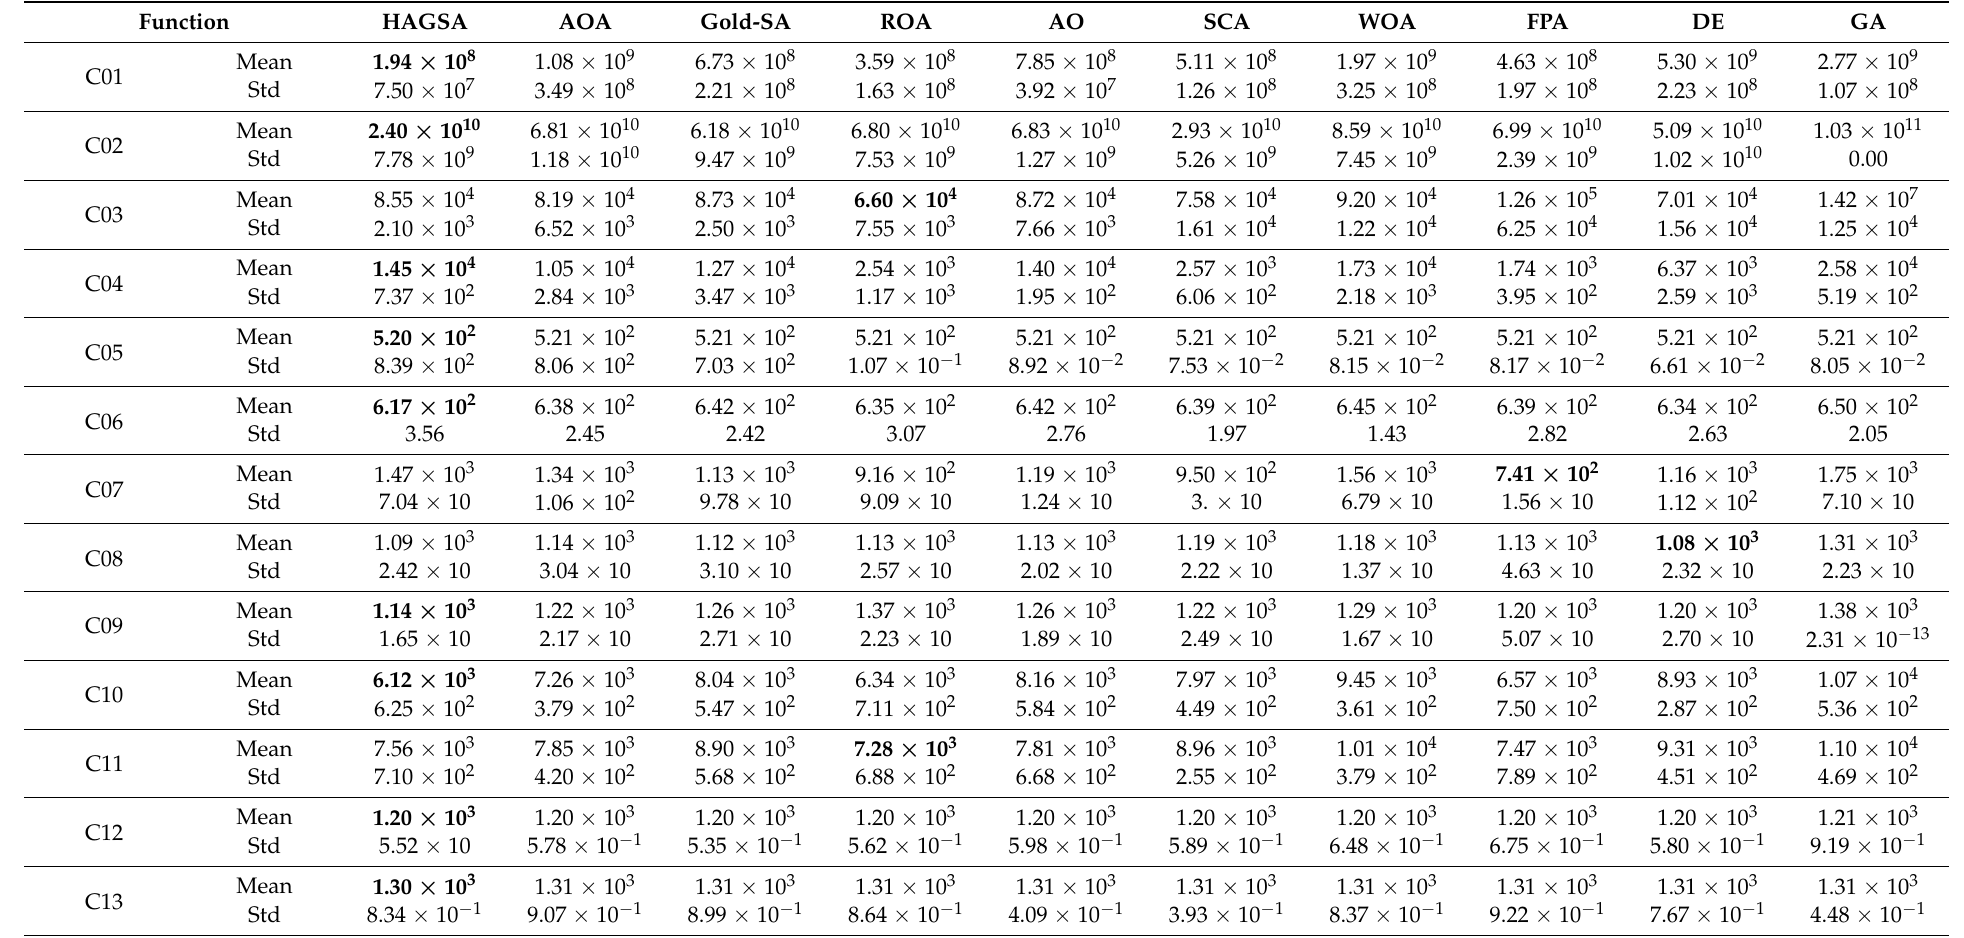
Table 3. The mean fitness and std obtained with the different algorithms on the CEC 2014 test